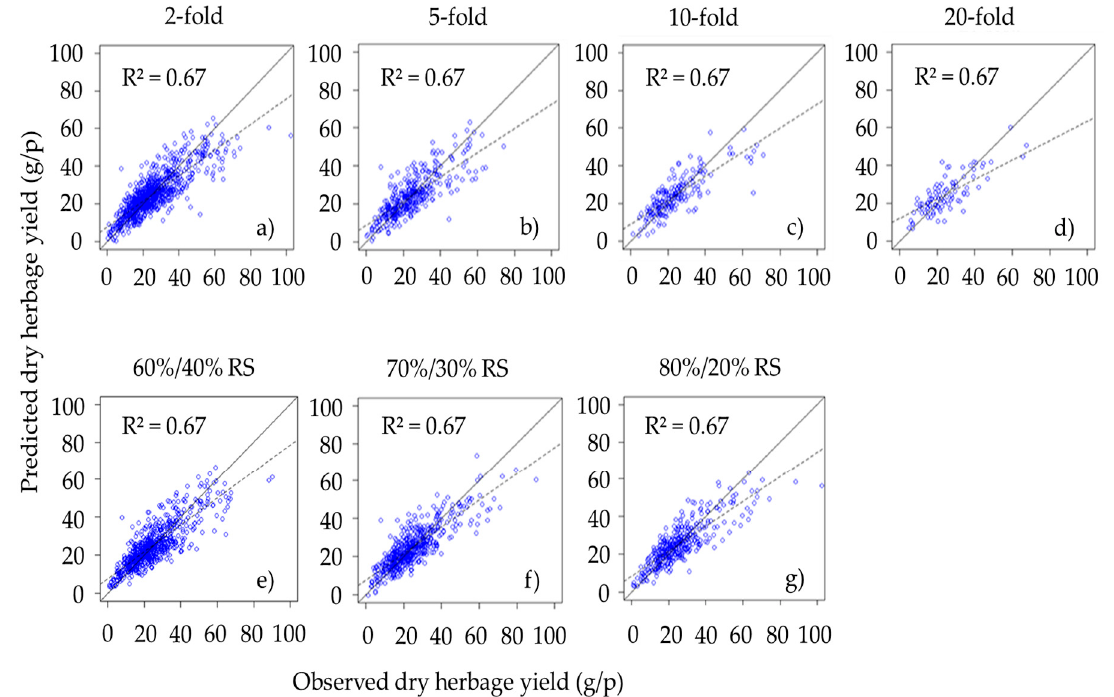
Figure 9. Scatterplots of observed and predicted dry herbage yield (grams / plant) in perennial ryegrass with linear regressions of various K-folds and random splits of cross-validation. The data points displayed in each plot represent the K-fold validation sets of ( a ) two-fold, ( b ) five-fold, ( c ) 10-fold, ( d ) 20- and ( e ) 60 / 40%, ( f ) 70 / 30% and ( g ) 80 / 20% random split from the 2017 harvest. The solid diagonals represent 1:1 line, and the dashed lines represent the fitted linear functions. p -value < 0.0001 for all regression functions .